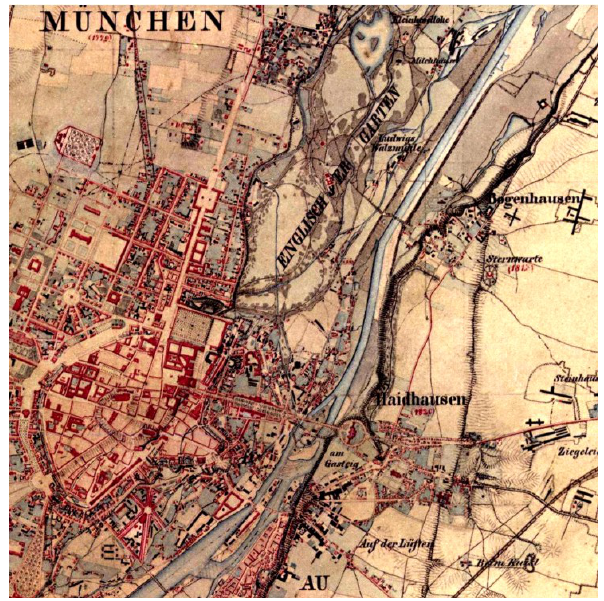
Figure 1. Partial view of the plan of Munich from 1820. In the Munich suburb of Haidhausen a small astronomical observatory existed before a new observatory building (Sternwarte) was built in 1816/1817 in the rural environment near the village of Bogen-